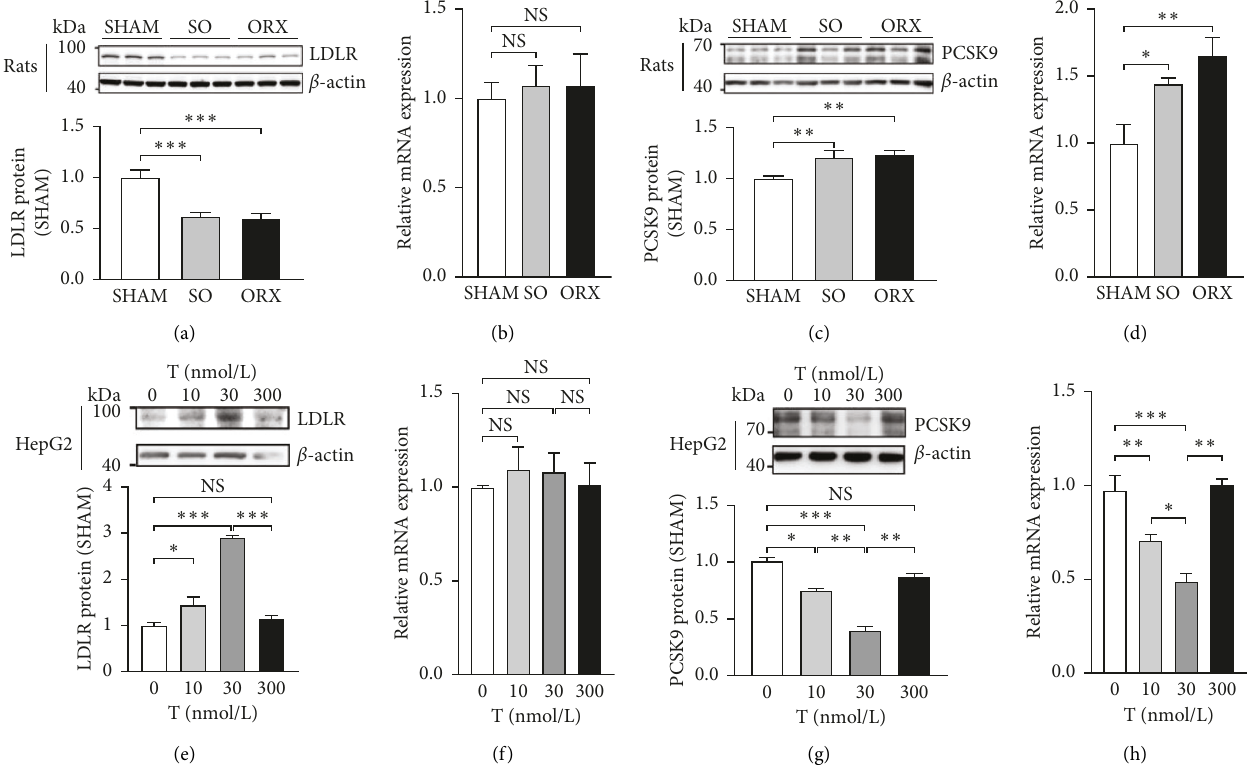
Figure 4: Testosterone deficiency reduces low-density lipoprotein receptor (LDLR) in liver by upregulating proprotein convertase subtilisin/kexin type 9 (PCSK9). Key mediators of liver cholesterol uptake LDLR and PCSK9 were analyzed in vivo and in vitro in different conditions of testosterone by western blotting and real-time quantitative PCR. ((a), (b)) LDLR and ((c), (d)) PCSK9 level in the liver of SHAM, SO, ORX rats. ((e), (f)) LDLR and ((g), (h)) PCSK9 level in HepG2 cells incubated with 0 (control), 10, 30, 300nM testosterone for 72h. Data are presented as mean SEM. Statistical analyses are one-way ANOVA. ±